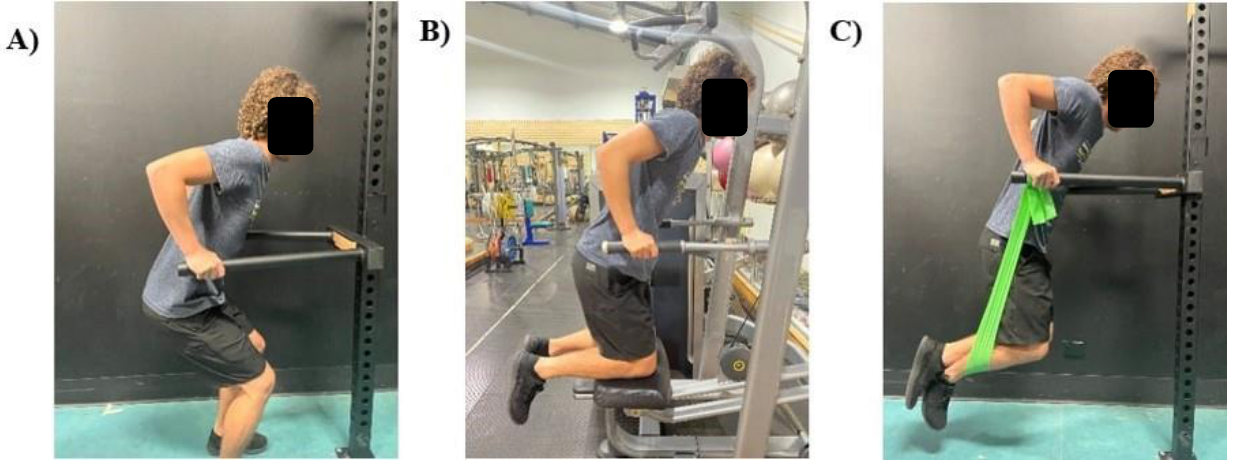
Figure 5. Examples of bar dip alternatives, that help exercisers moderate load at the point of maximal shoulder extension. ( A ) standing bar dips, ( B ) assisted bar dips, and ( C ) banded bar dips.